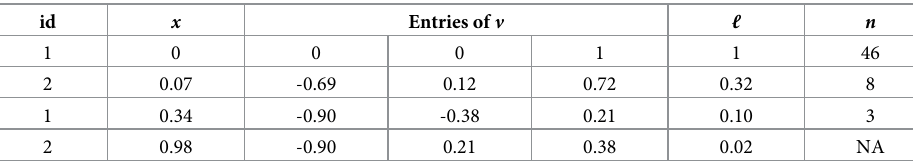
Table 1. The data entries for a level 4 branch of Pixie